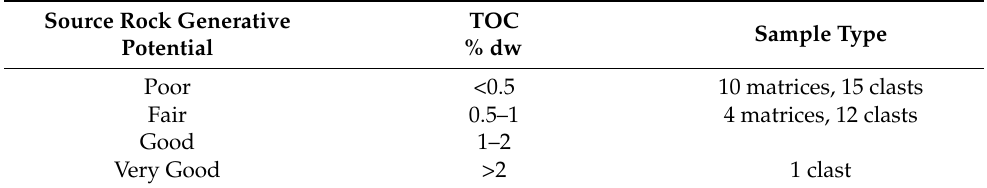
Table 2. Source rock hydrocarbon-generation potential based on the TOC contents of the pyrolyzed sediment samples. Redrawn and modified from Peters [58]. Source Rock Generative Potential